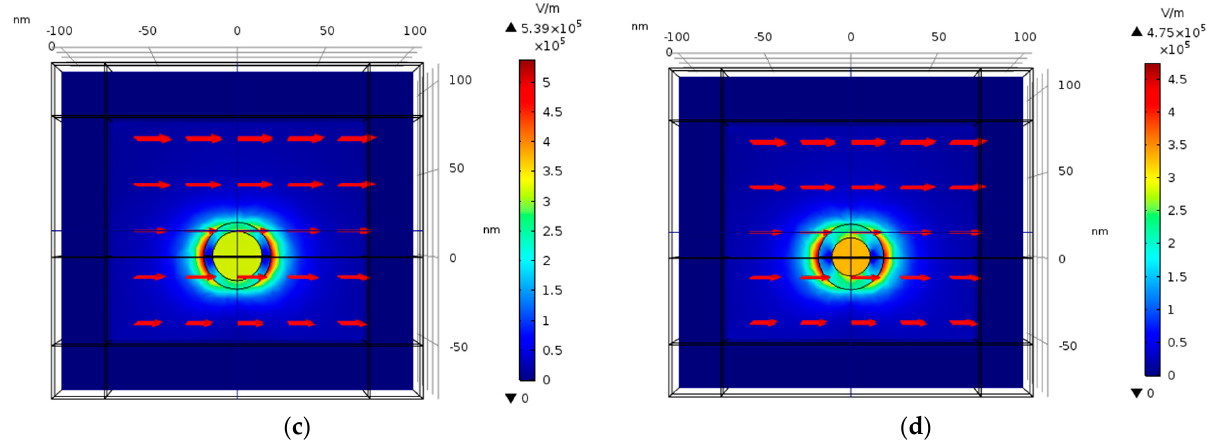
Figure 16. Simulation of nano-shells with thickness (T) ranging from 1.433 to 8.303 nm. The impinging electric field is polarized in the Y direction as shown by the red arrows and the wave front direction (K vector) is in the -Z direction. Δ = 0.2 ( a ), Δ = 0.4 ( b ), Δ = 0.6 ( c ), and Δ = 0.8 ( d ), where Δ = 1-(r/R) 3 .